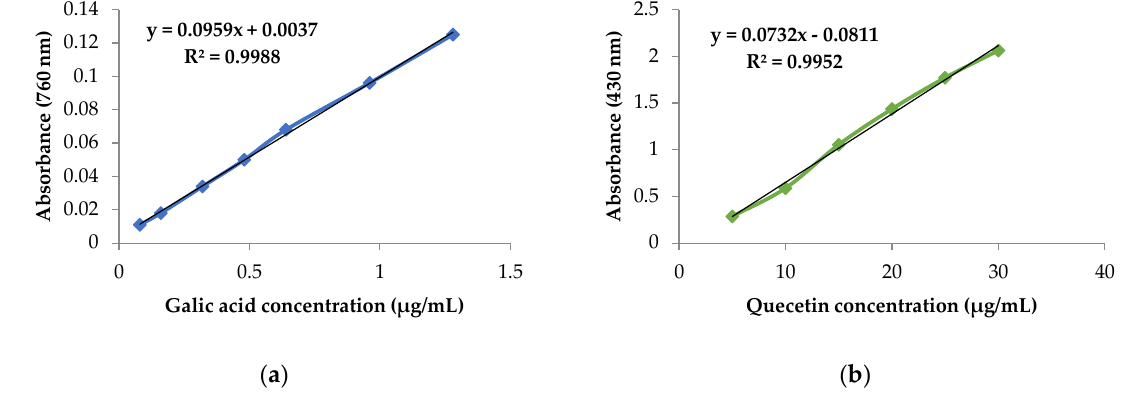
Figure 4. Calibration curves of ( a ) gallic acid and ( b ) quercetin.